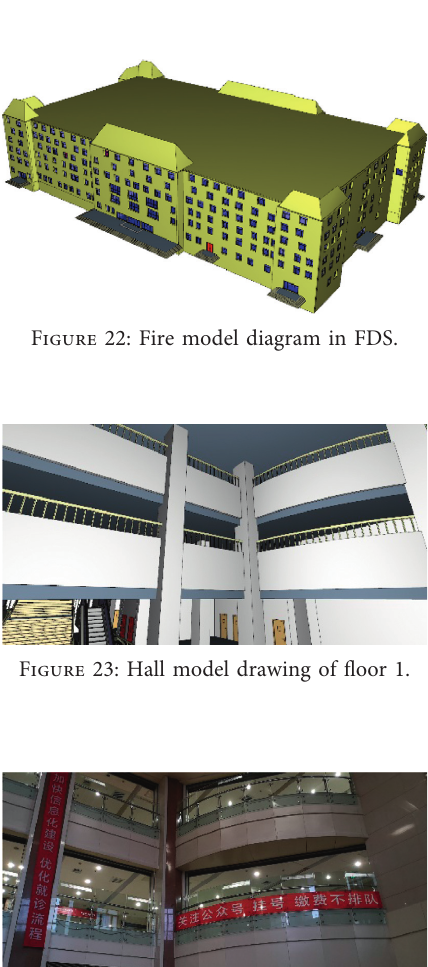
Figure 16: Fire model diagram of floor 1.